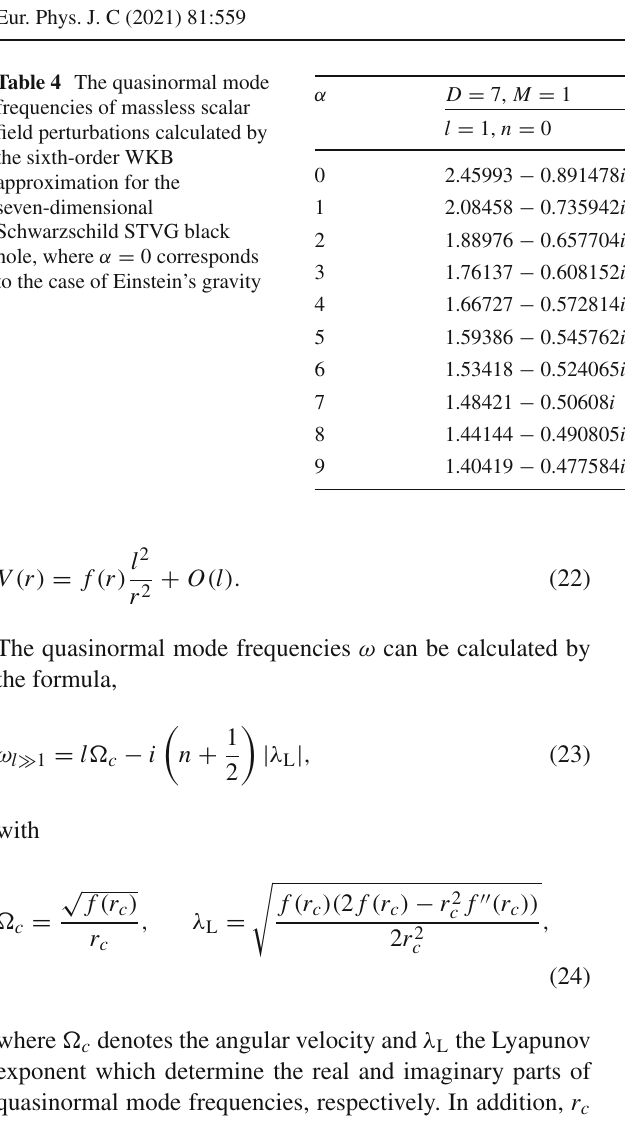
negative imaginary parts monotonically